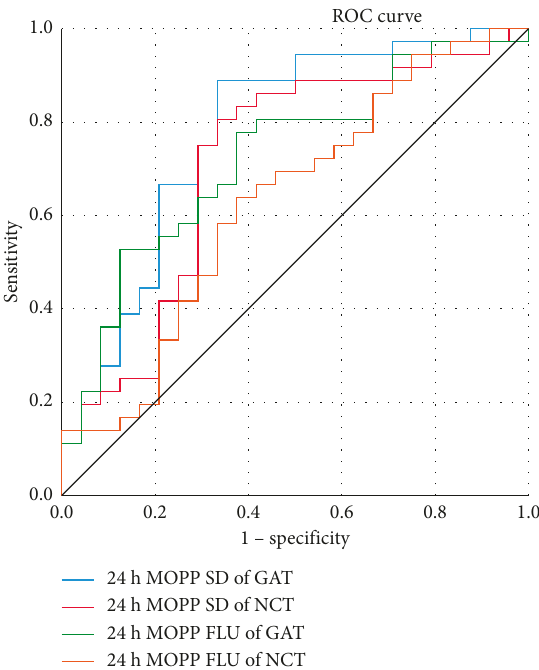
Figure 3: ROC curve for the 24-hour MOPP SD and fluctuation measured by the NCT and GAT. (SD: